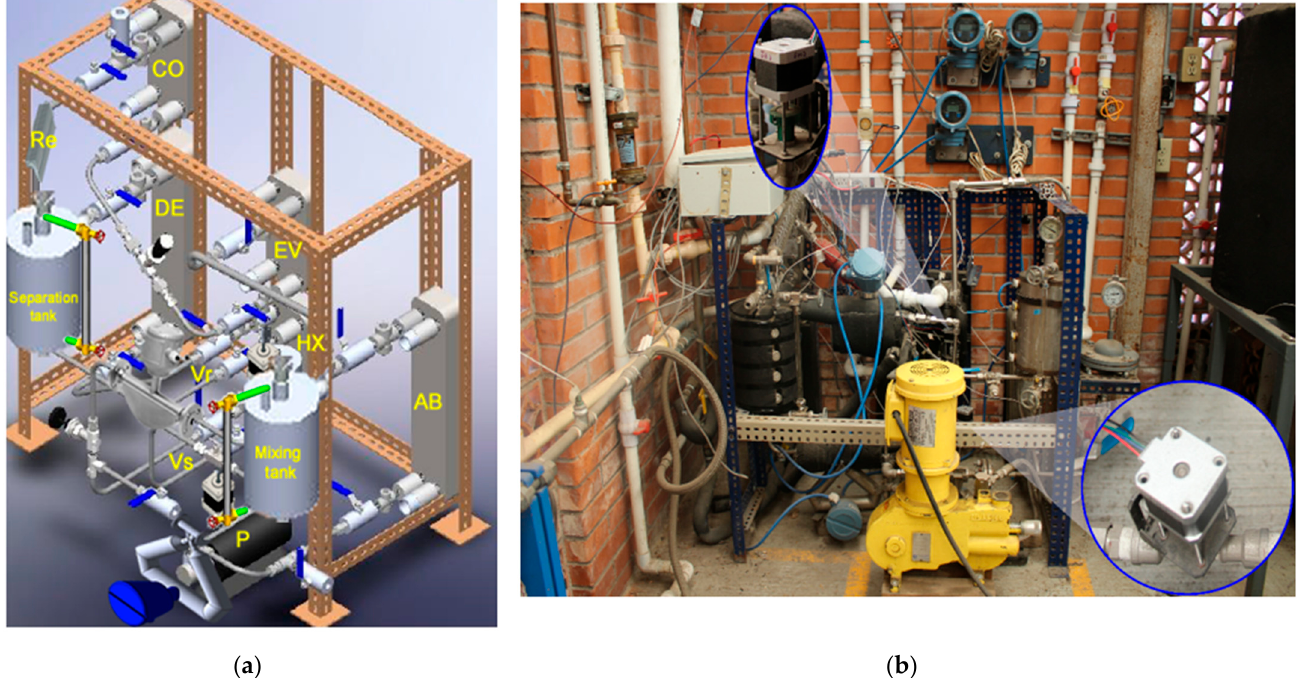
Figure 2. ( a ) Layout of experimental SACS design. ( b ) Real experimental SACS setup; insets show the stepper motors for controlling the expansions valves.